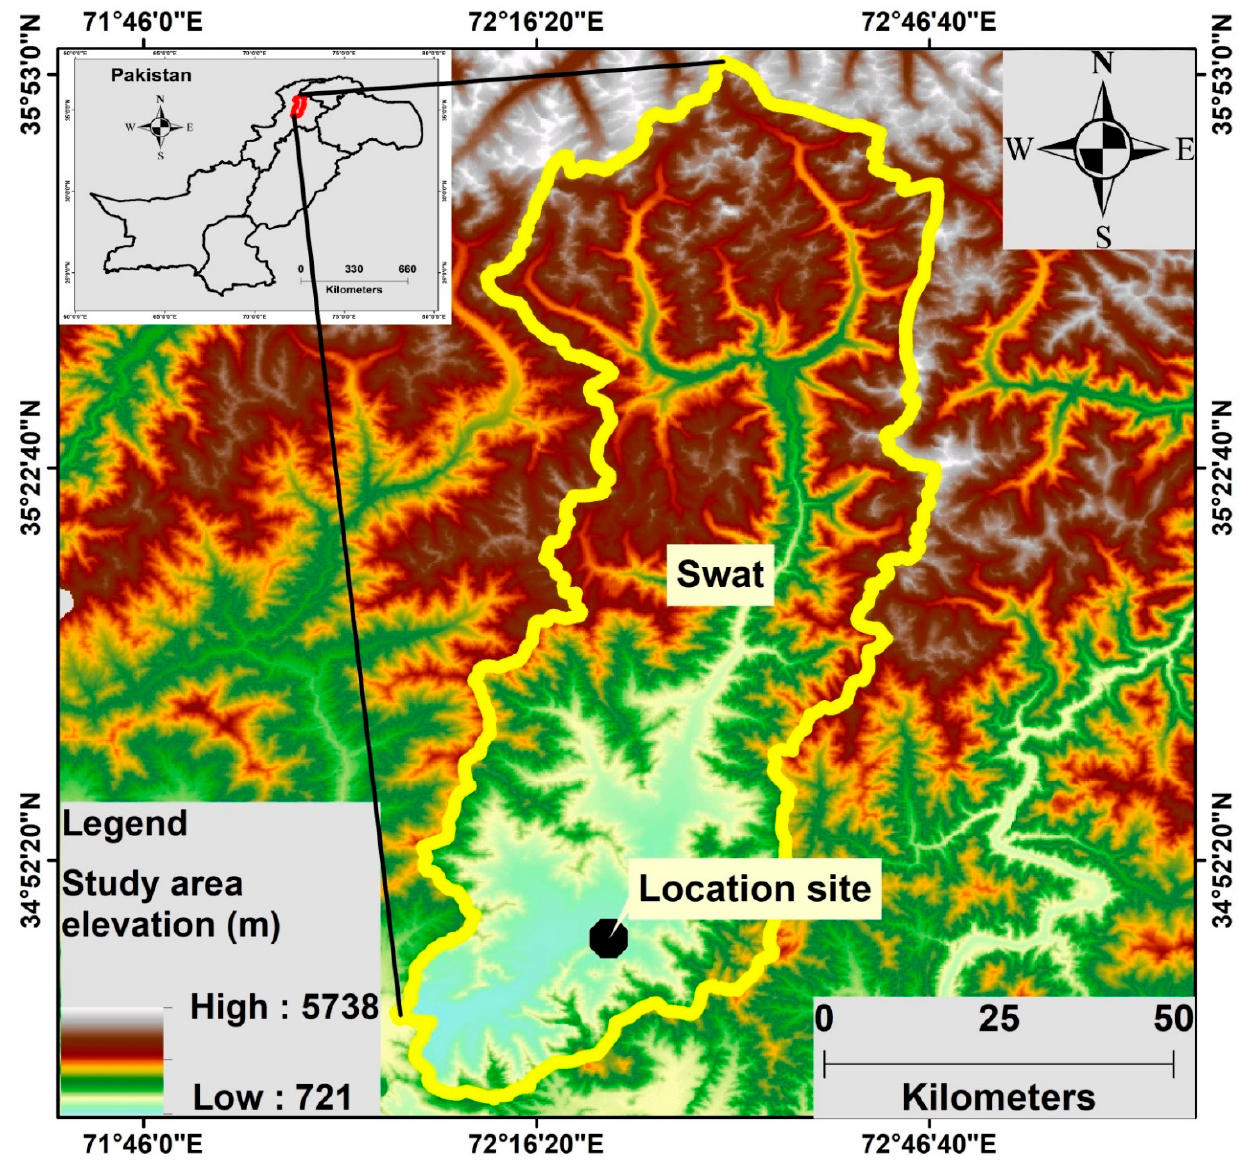
Figure 1. Map of the study location.